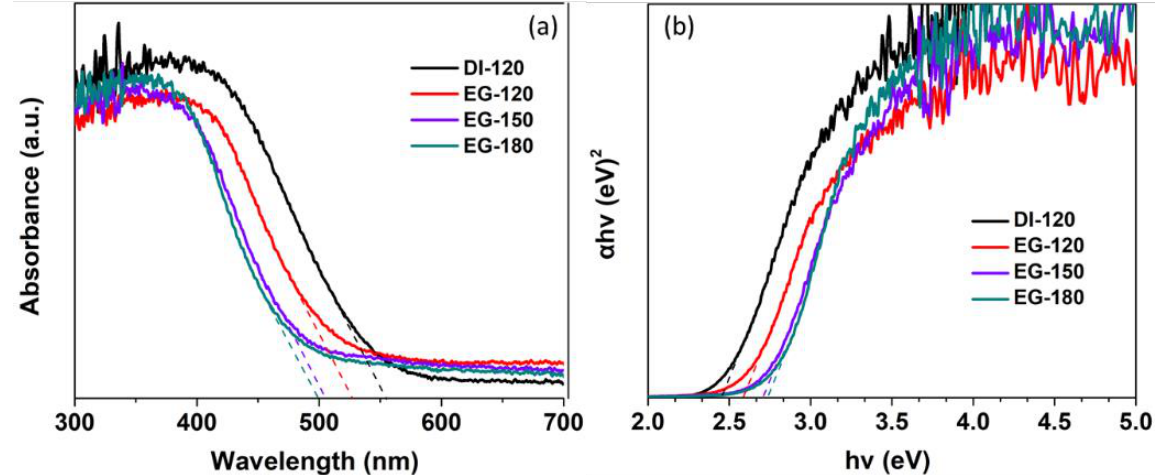
Figure 4. ( a ) UV – vis DRS and ( b ) Plot of (αhν) 2 vs. hν for the band gap energy of different ZnIn 2 S 4 Figure 4. ( a ) UV–vis DRS and ( b ) Plot of ( α h ν ) 2 vs. h ν for the band gap energy of different ZnIn 2 S 4 Catalysts 2022 , 12 , x FOR PEER REVIEW photocatalysts. photocatalysts.